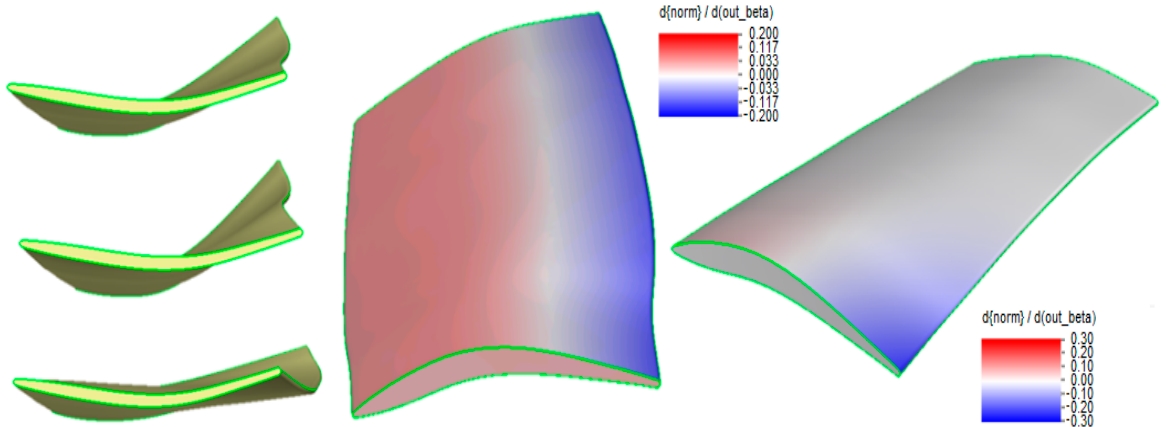
Figure 16. TE perturbation with three different spanwise distributions (left); sensitivity to all TE blade angles changing (center) and to TE blade angle at hub alone.